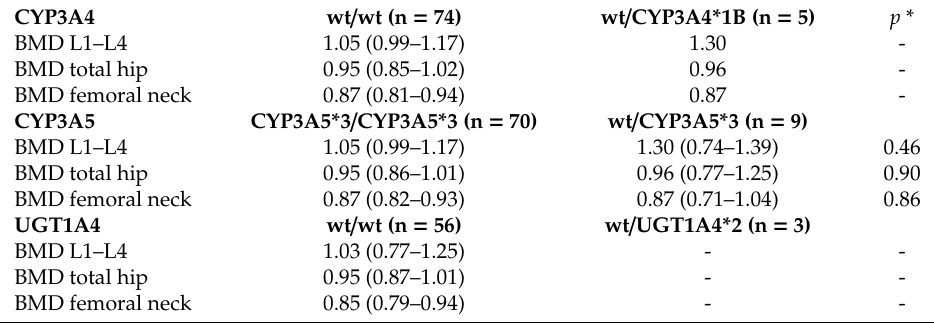
Table 5. Di ff erences in BMD according to CYP3A4, CYP3A5 and UGT1A4 polymorphisms in the group before anastrozole